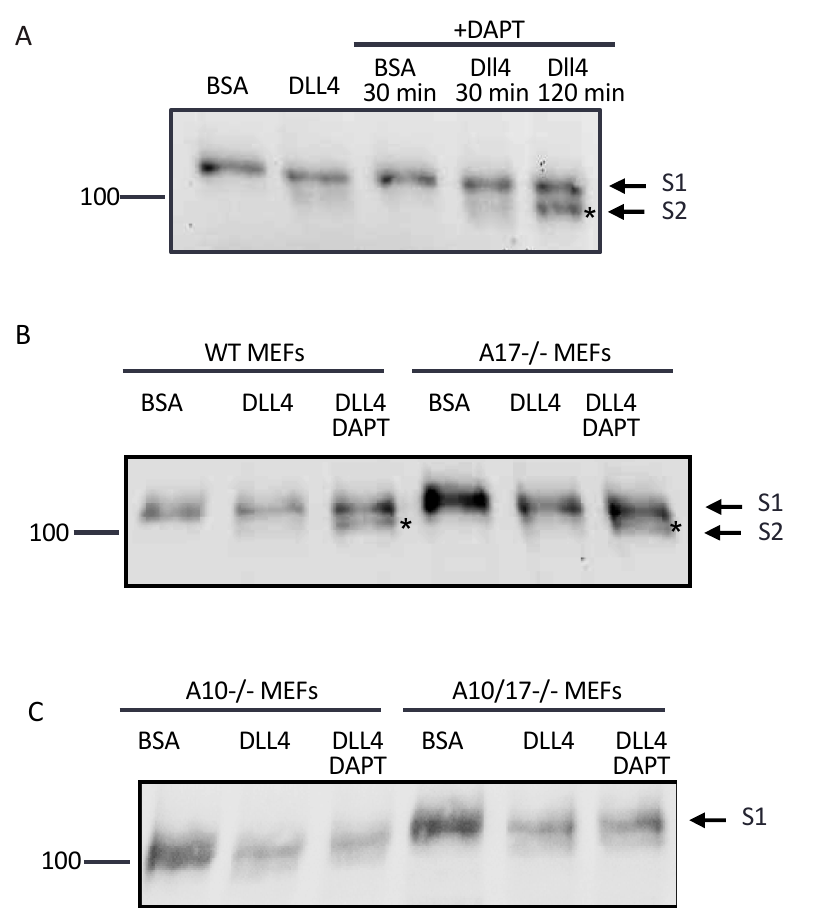
Figure 3. ADAM10, and not ADAM17, cleaves the S2 site in Dll4 ligand-induced endogenous Notch1 processing. Cells were plated on tissue culture dishes coated with 1 µ g/mL of the Notch1 ligand Dll4 in bovine serum albumin (BSA) or with BSA alone. Cells were starved in Opti-MEM for 2 h prior to treatment with DAPT or incubated with Opti-MEM alone for an additional 30 min or 120 min. ( A ) WT mEFs plated on Dll4 alone showed the minimal accumulation of an S2 product. Treatment with DAPT for 30 min resulted in very little accumulation of S2 compared to the accumulation after 120 min of DAPT treatment, when the S2 accumulation was substantial. ( B ) In WT mEFs, S2 product accumulated in cells plated on Dll4 that were treated with DAPT for 2 h. A similar accumulation of S2 product in DAPT-treated cells was apparent in A17-/- mEFs plated on Dll4. ( C ) In contrast, A10-/- mEFs, similar to A10/17-/- mEFs, plated on Dll4 showed no accumulation of S2 in the presence of DAPT. The Western blots are representative of at least 3 independent experiments.